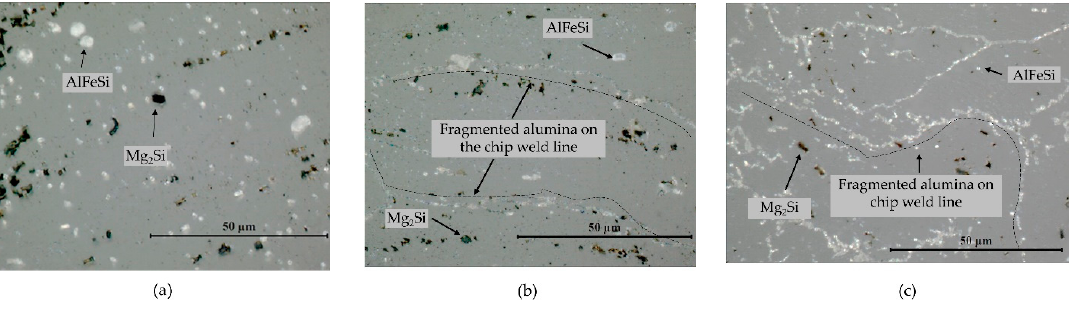
Figure 6. Microstructure of the extrudate; ( a ) as-received; ( b ) untreated chip; ( c ) 500 °C thermally-treated chip.